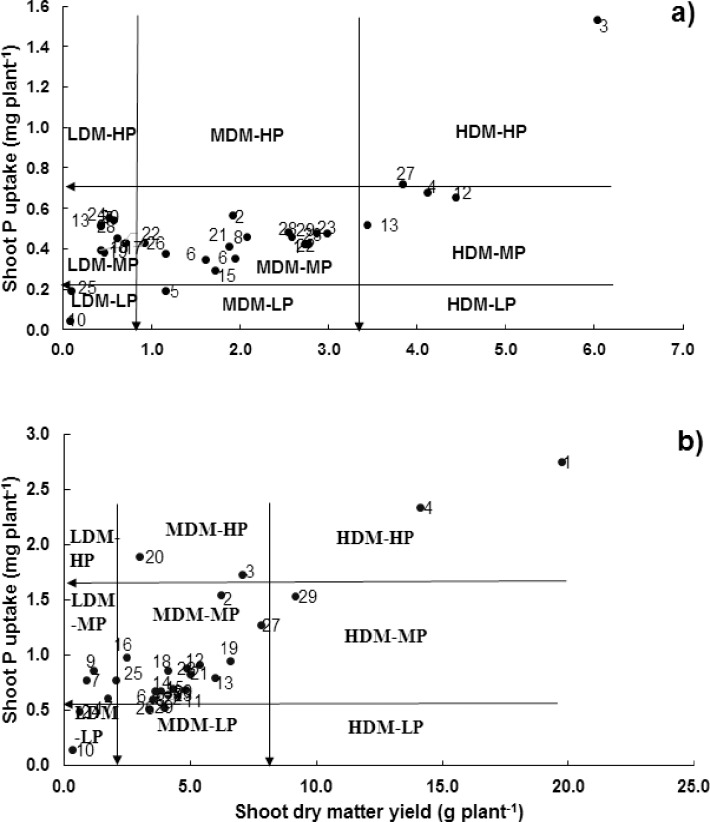
Classification of wheat genotypes at vegetative growth stage (in hydroponic) for P utilization efficiency a) at deficit P and b) at adequate P supply. Data are the mean value of four replicates. This categorization divides genotypes into nine categories i.e. low dry matter-low P (LDM-LP), low dry matter-medium P (LDM-MD), low dry matter-high P (LDM-HP), medium dry matter-low P (MDM-LP), medium dry matter-medium P (MDM-MP), medium dry matter-high P (MDM-HP), high dry matter-low P (HDM-LP), high dry matter-medium P (HDM-MP) and high dry matter-high P (HDM-HP) [30].